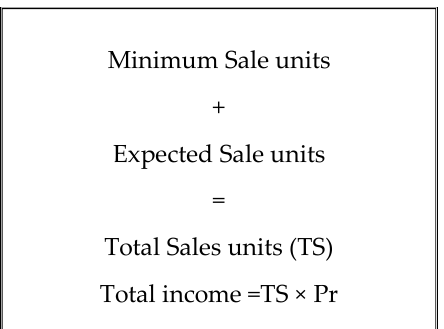
Figure 3. Income component.